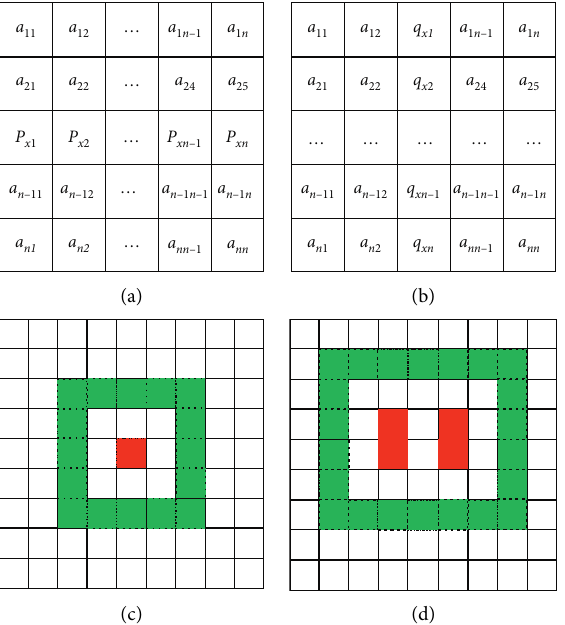
Figure 4: IoT-based node distribution of logistics supply chain with horizontal (a, c) and vertical integration modes (b,